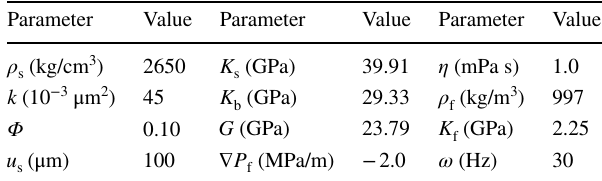
Table 1 Initial parameters used in the numerical